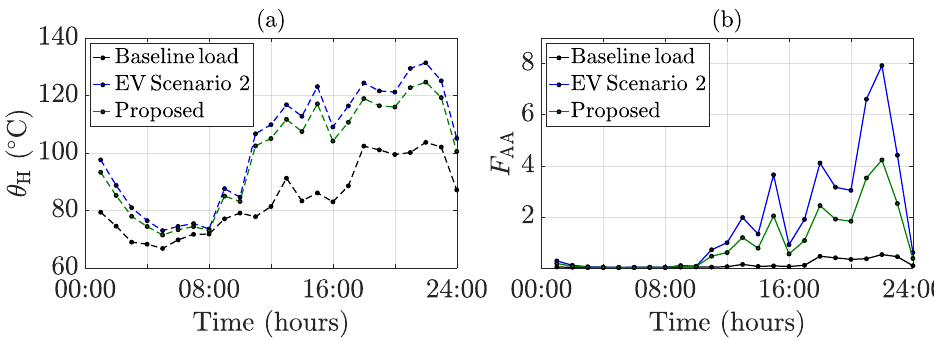
Figure 11. Transformer life indices in scenario 2, ( a ) hottest-spot temperature, θ H ; ( b ) accelerated aging factor, F AA